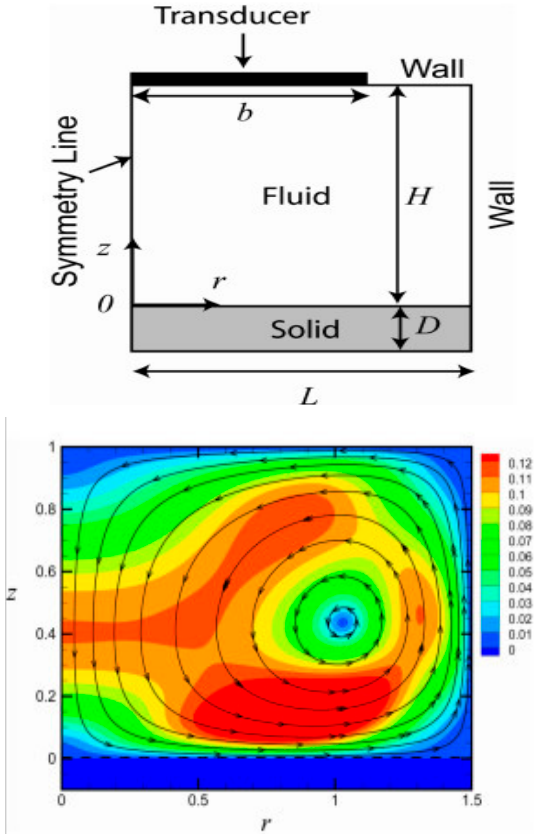
Figure 6. Top figure ( a ) shows dimension of a cylindrical container in a cylindrical coordinates; The bottom ( b ) is color-coded acoustic streaming field distribution in the same system adapted from [48]. Reproduced with permission from [33].